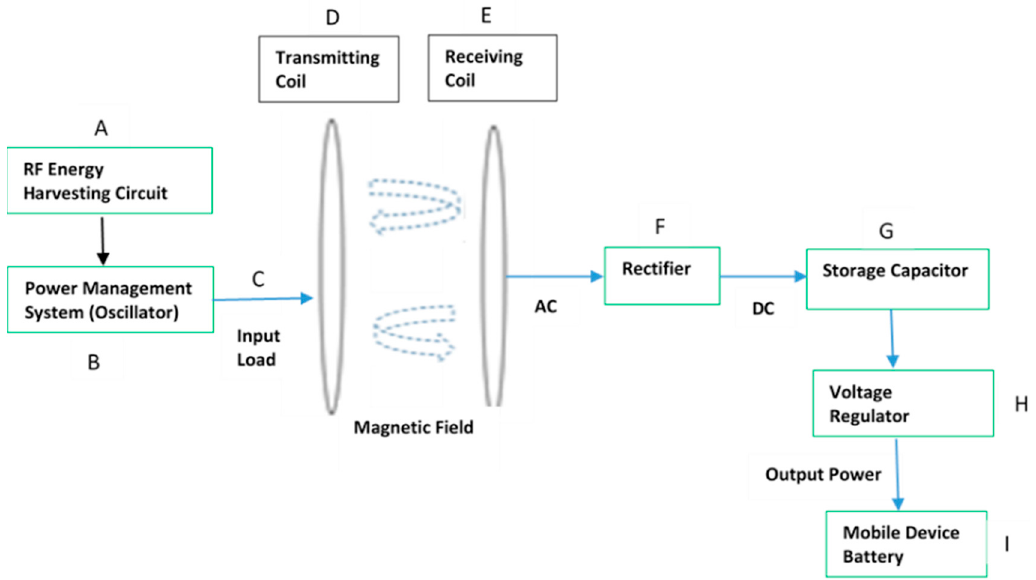
Figure 1. Block diagram for the wireless power transfer prototype circuit.